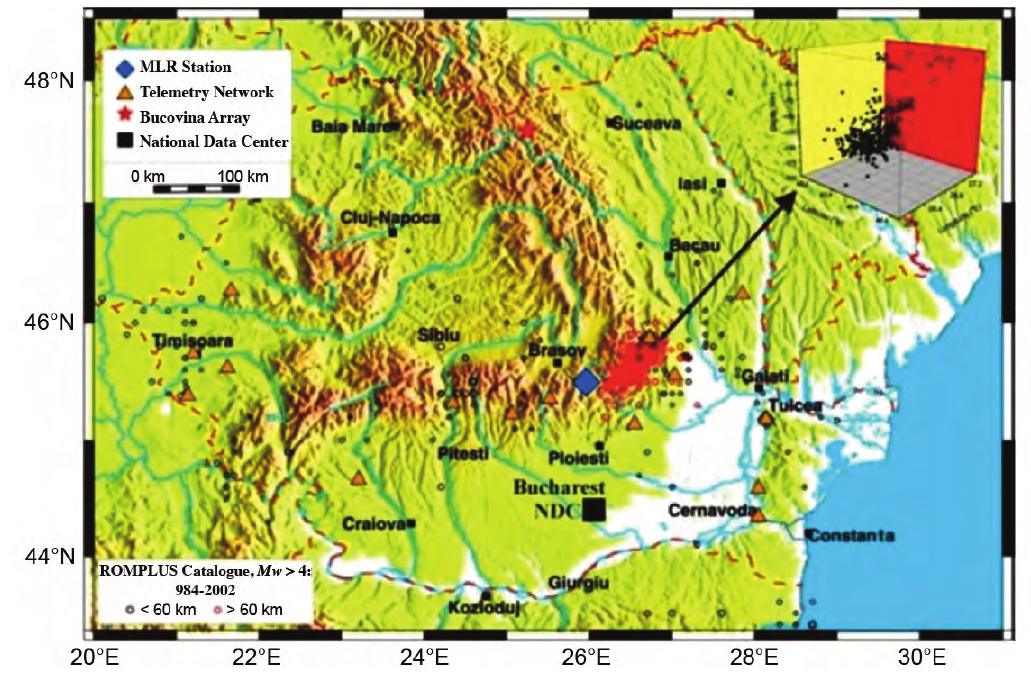
Figure 1. Distribution of the epicenters and hypocenters of the Vrancea (Romania) earthquakes. Blue diamond, the geomagnetic MLR Observatory; black square, the National Data Center from Bucharest; red dots, the Vrancea